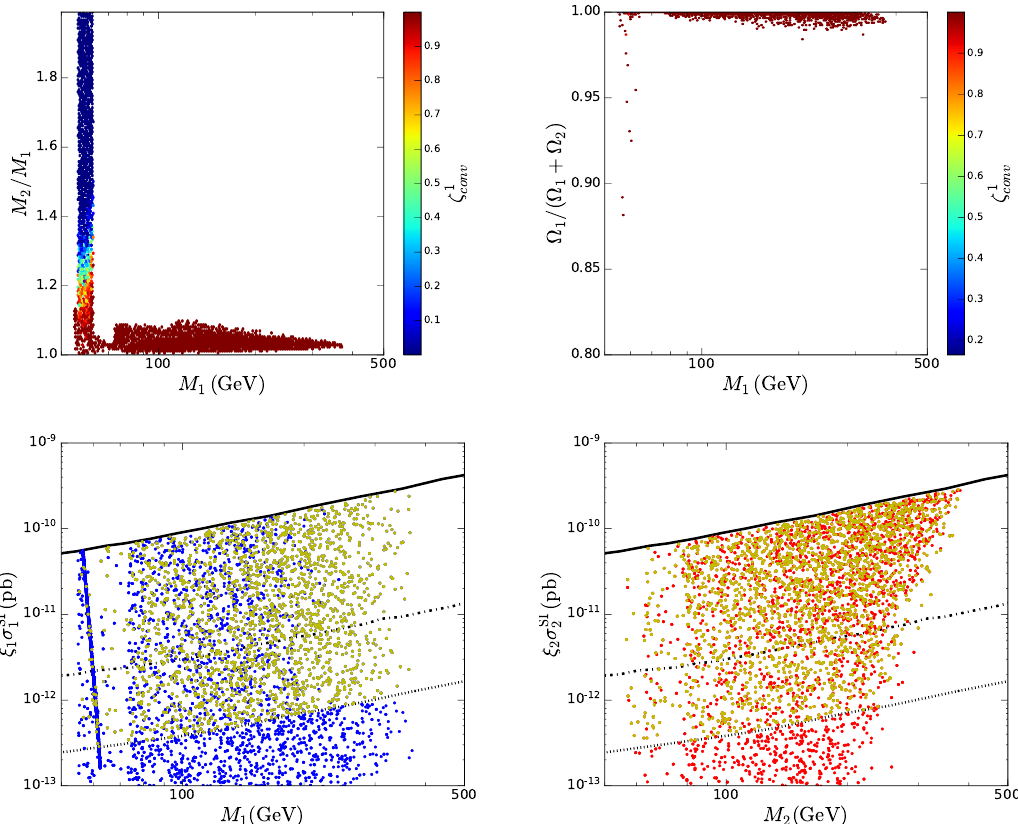
Figure 14 . Scan results for (cid:22) Si = 0 with (cid:21) 3 i 6 = 0 ; (cid:21) 412 6 = 0. Top panels: M 2 =M 1 (left) and relative contribution of (cid:30) 1 to the total DM relic abundance (right) as a function of M 1 . Bottom panels: spin-independent cross-sections for elastic scattering of (cid:30) i with nuclei scaled by (cid:24) i . The solid line is the upper limit set by XENON1T collaboration [25] while the dot-dashed and dotted lines show the projected sensitivity of LZ [26] and DARWIN [27] experiments. Yellow points indicate that both DM particles lay within the sensitivity region of